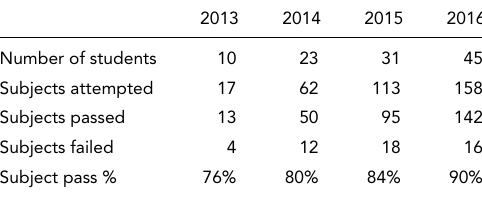
Snapshot of Results of Indigenous Students at Bond University Between 2013–2016 (Bond University,